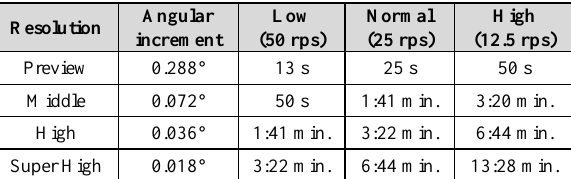
Table 1. Scanner performance of a Z+F